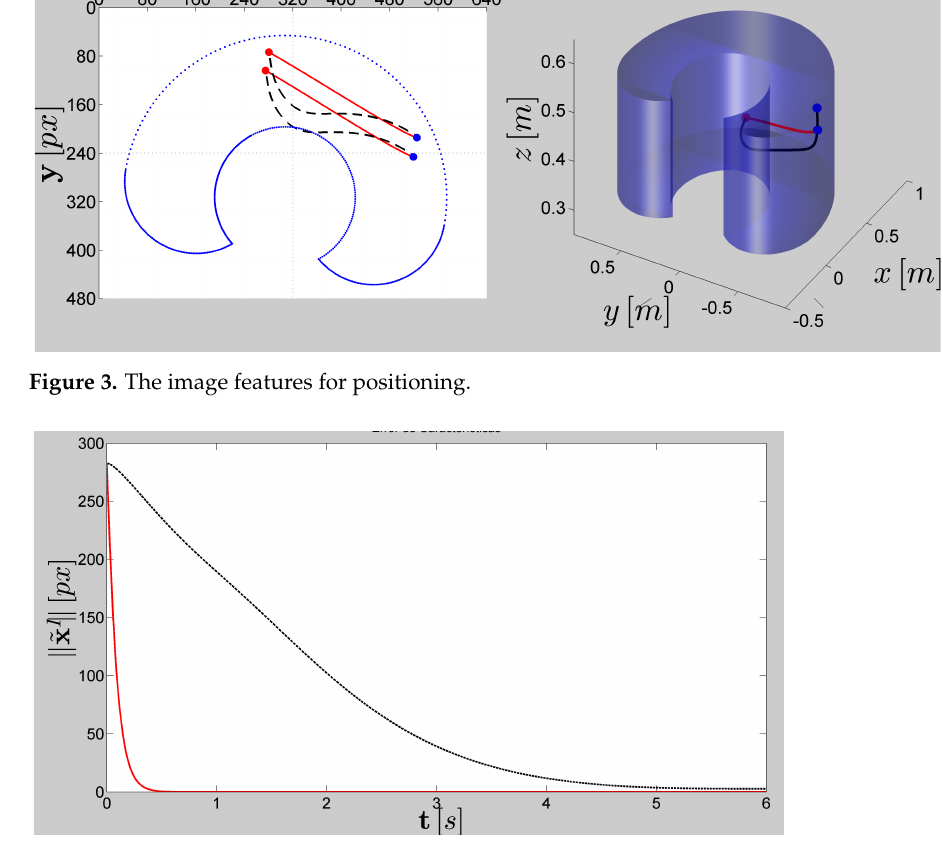
Figure 4. The control error for